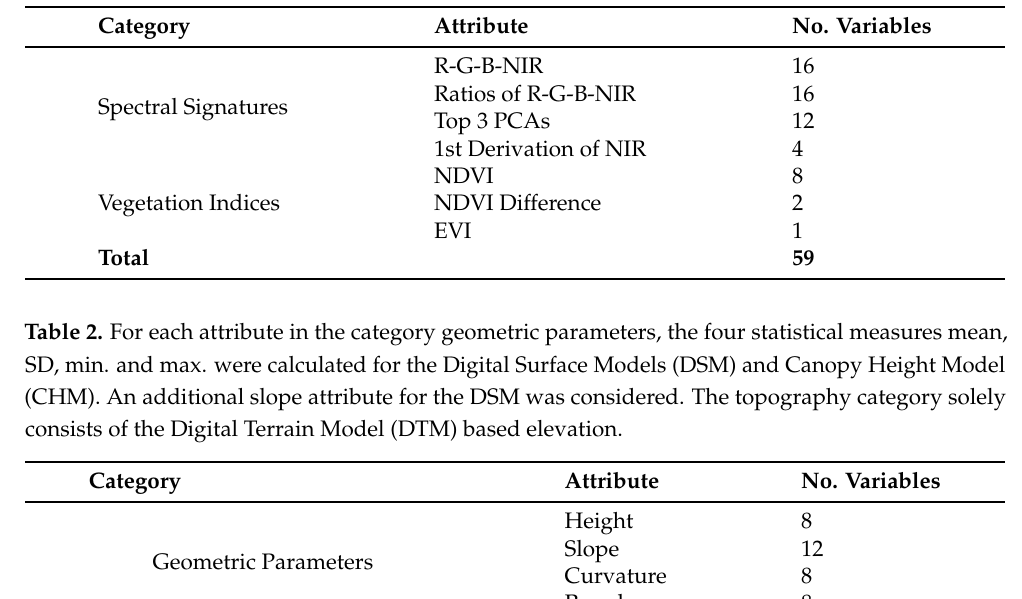
Table 1. Within the two optical categories of spectral signatures and vegetation indices, for each of the attributes, the four statistical measures mean, SD, min and max were calculated. Exceptions are the NDVI differences and EVI, where only the mean values were considered.